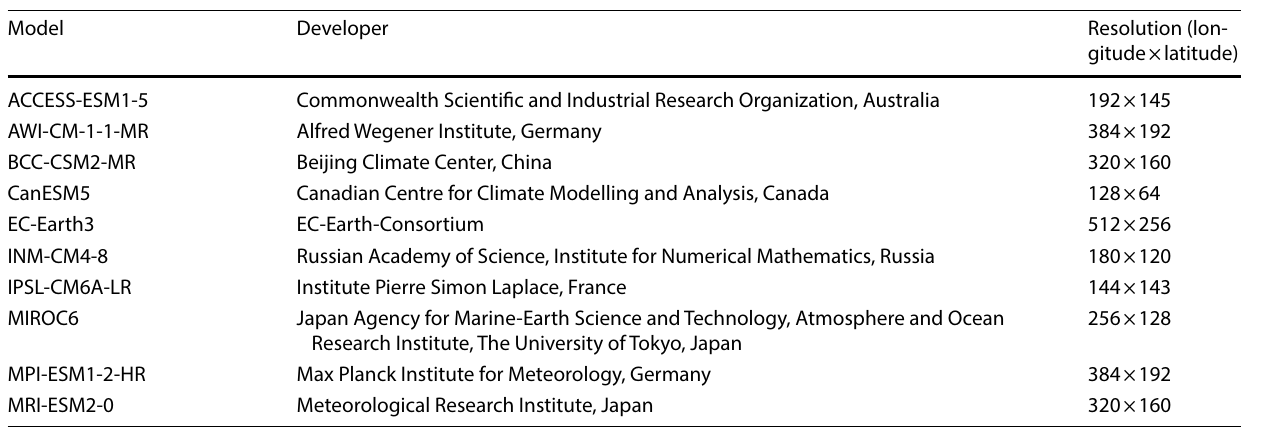
Table 1 The selected 10 models in CMIP6